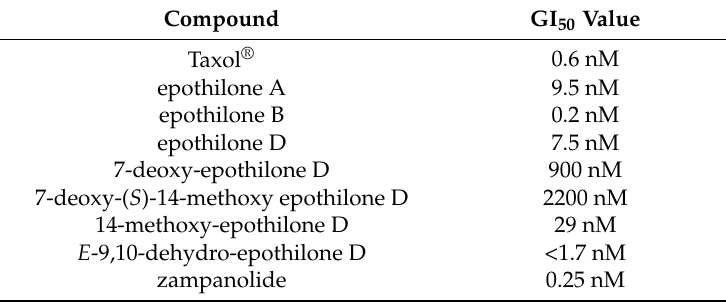
Table 1. Comparative GI 50 values of natural and synthetic microtubule stabilizers in A2780 (1A9) human ovarian carcinoma cell lines.